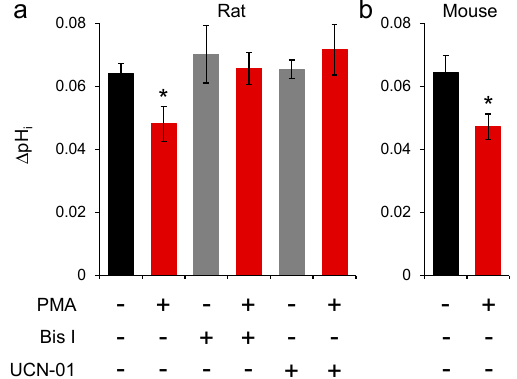
Figure 2. Conventional PKC isoforms reduce SNAT3 function. ( a ) Glutamine-induced alkalinisations in rat astrocytes, recorded after pre-incubation of slices in PMA or pharmacological analogues. 1 h incubation with 100 nM PMA reduces the SNAT3-meidated alkalinisation to 0.048 ± 0.005 pH units ( n = 7; * p <0.05). 100 nM Bis I does not affect the SNAT3 function (0.070 ± 0.009 pH units; n = 7; p = 0.36) but does inhibit the action of PMA (0.066 ± 0.005 pH units; n = 7; p = 0.78). 10 nM UCN-01 also does not affect SNAT3 function (0.065 ± 0.003 pH units; n = 5; p = 0.86) but inhibits PMA action (0.071 ± 0.008 pH units; n = 5; p = 0.32); ( b ) Glutamine-induced alkalinisation in mouse astrocytes, similarly incubated for 1 h in control or 100 nM PMA containing solution. PMA induces a reduction in SNAT3-mediated alkalinisation to 0.047 ± 0.004 pH units ( n = 13; * p